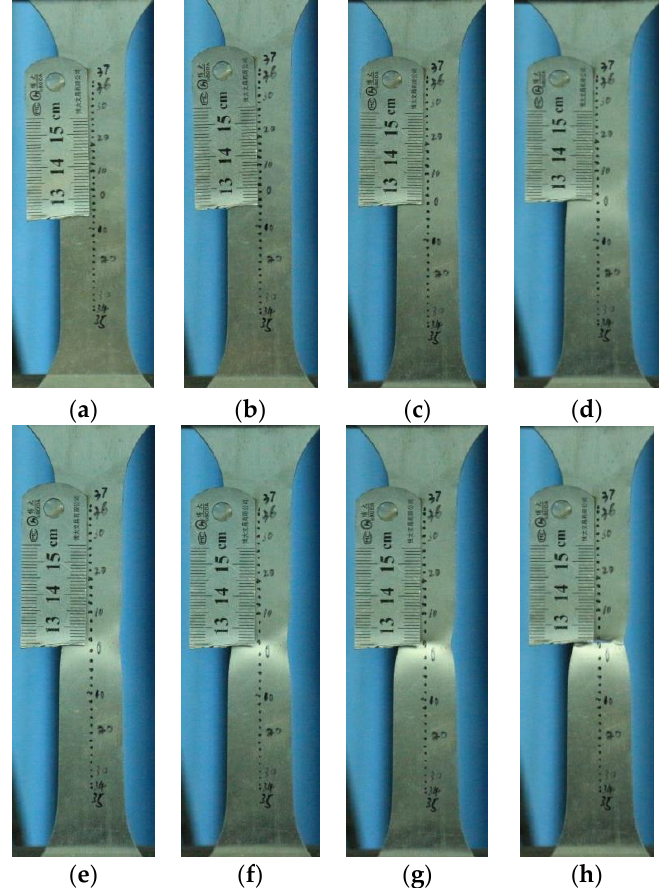
Figure 5. Stretching process of the specimen. ( a ) chuck displacement 1.3 mm; ( b ) chuck displacement 6.4 mm; ( c ) chuck displacement 15.6 mm; ( d ) chuck displacement 17.6 mm; ( e ) chuck displacement